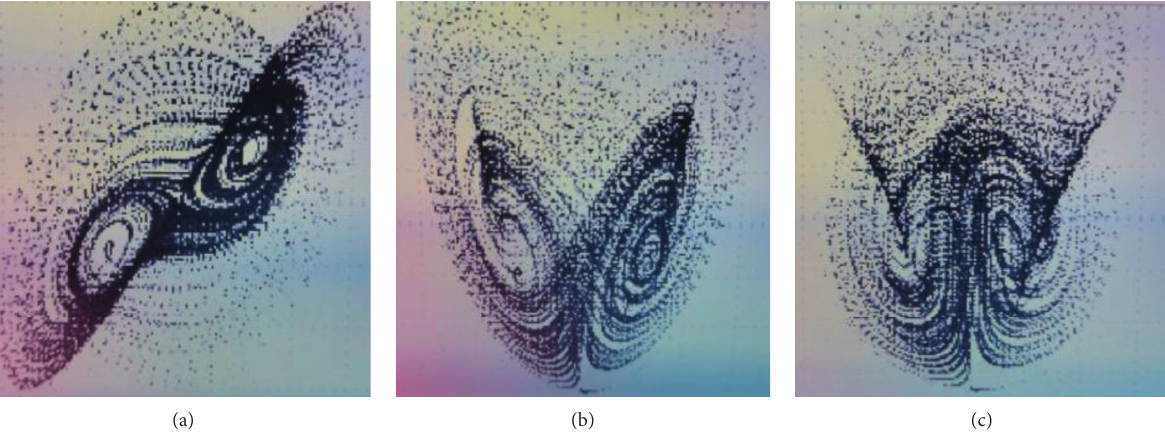
Figure 13: The chaotic attractor of system (1) with q � 0.98. (a) x - y plane, (b) x - z plane, and (c) y - z